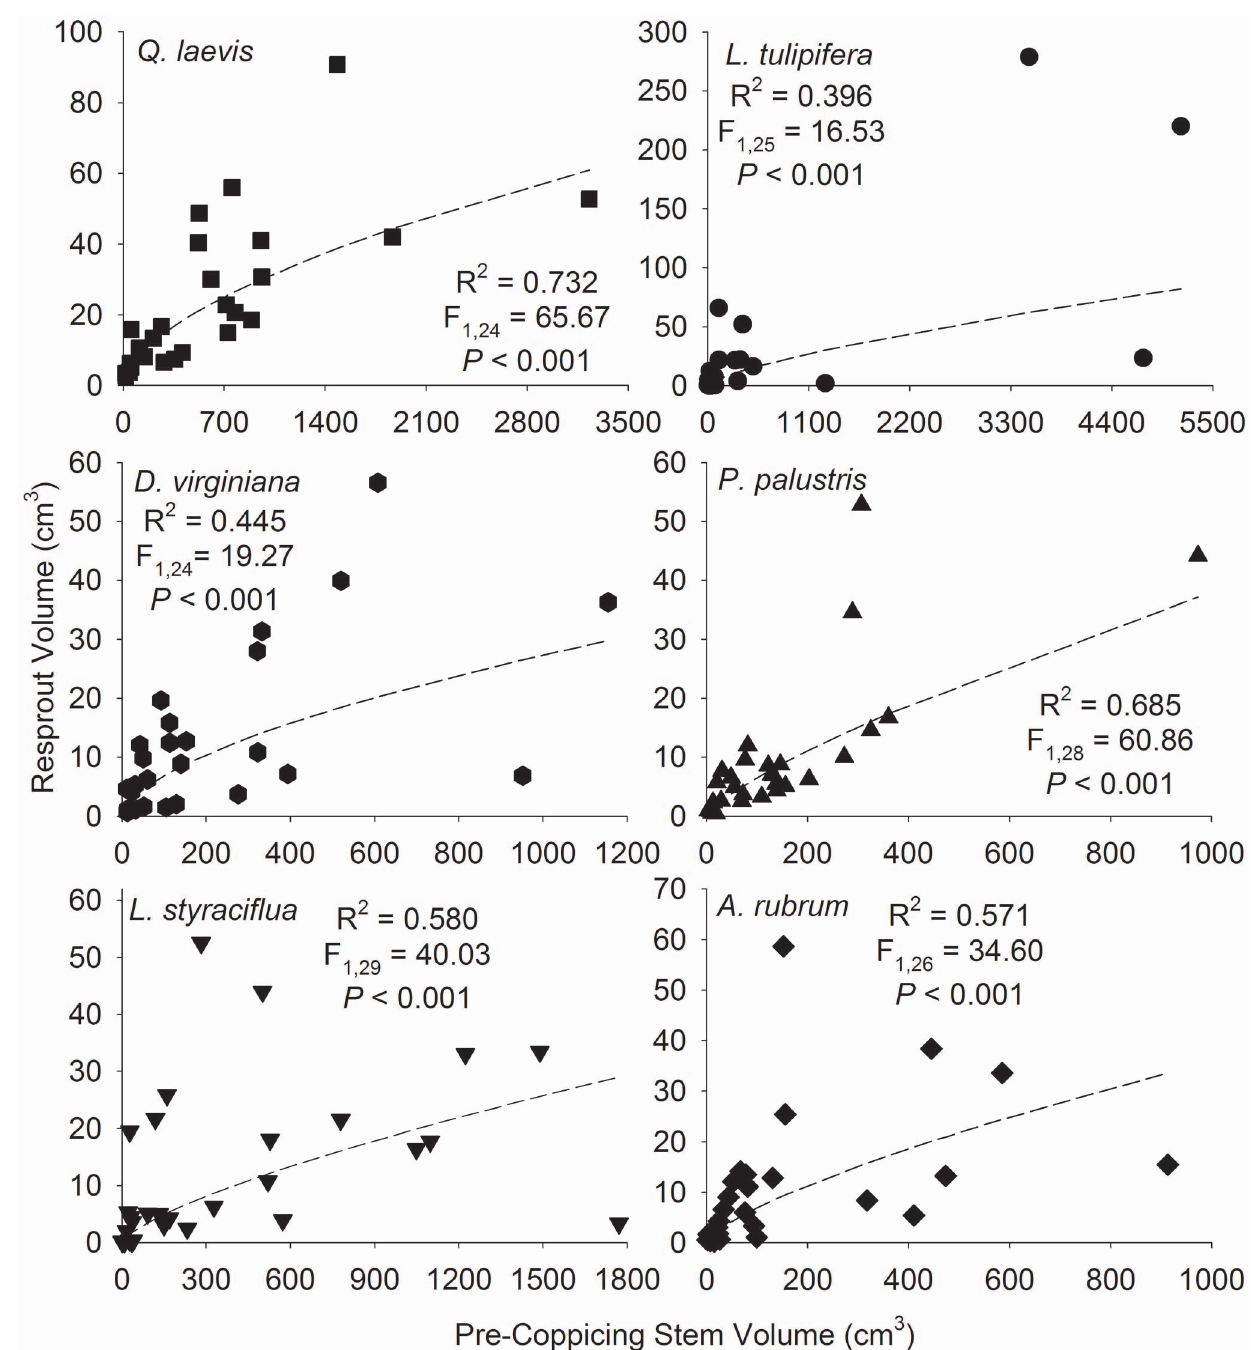
Figure 3. Curvilinear relationships between total pre-coppicing stem volume and total resprout stem volume.